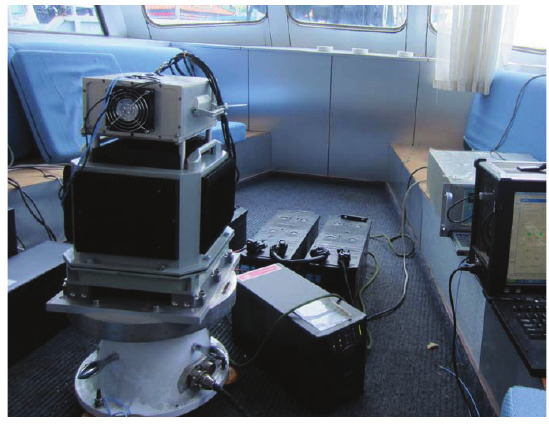
Figure 13. Single-axis RSINS.